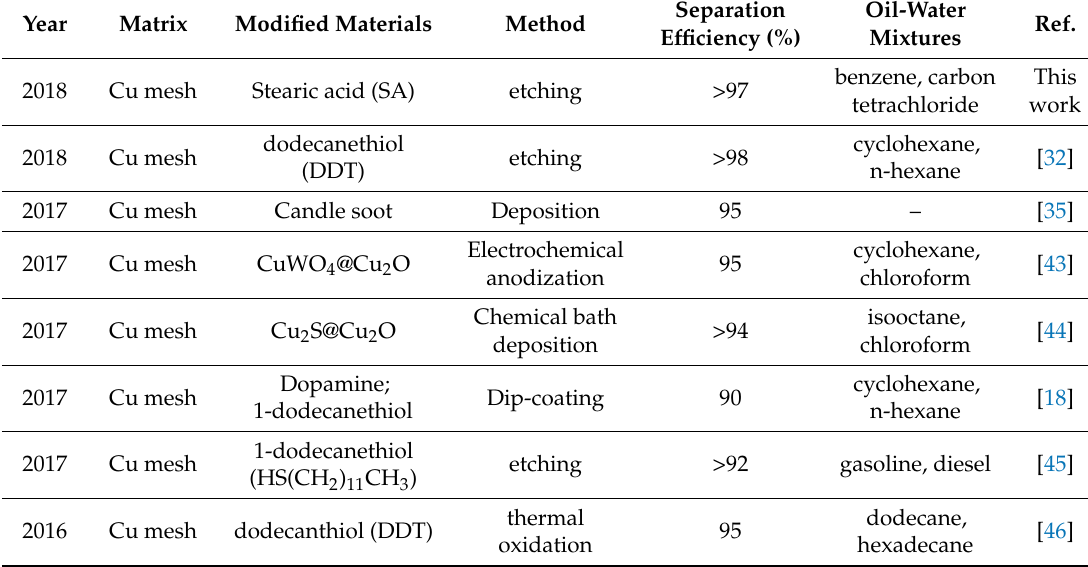
Table 2. Comparison of the copper mesh membranes materials for oil/water separation.